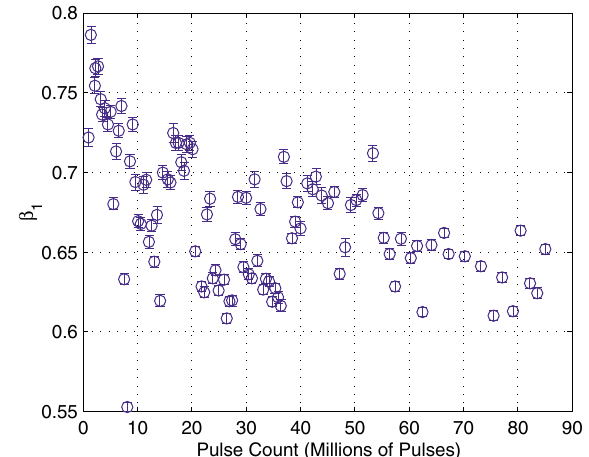
FIG. 23. (Color) Measurement of (cid:25) test for the TE